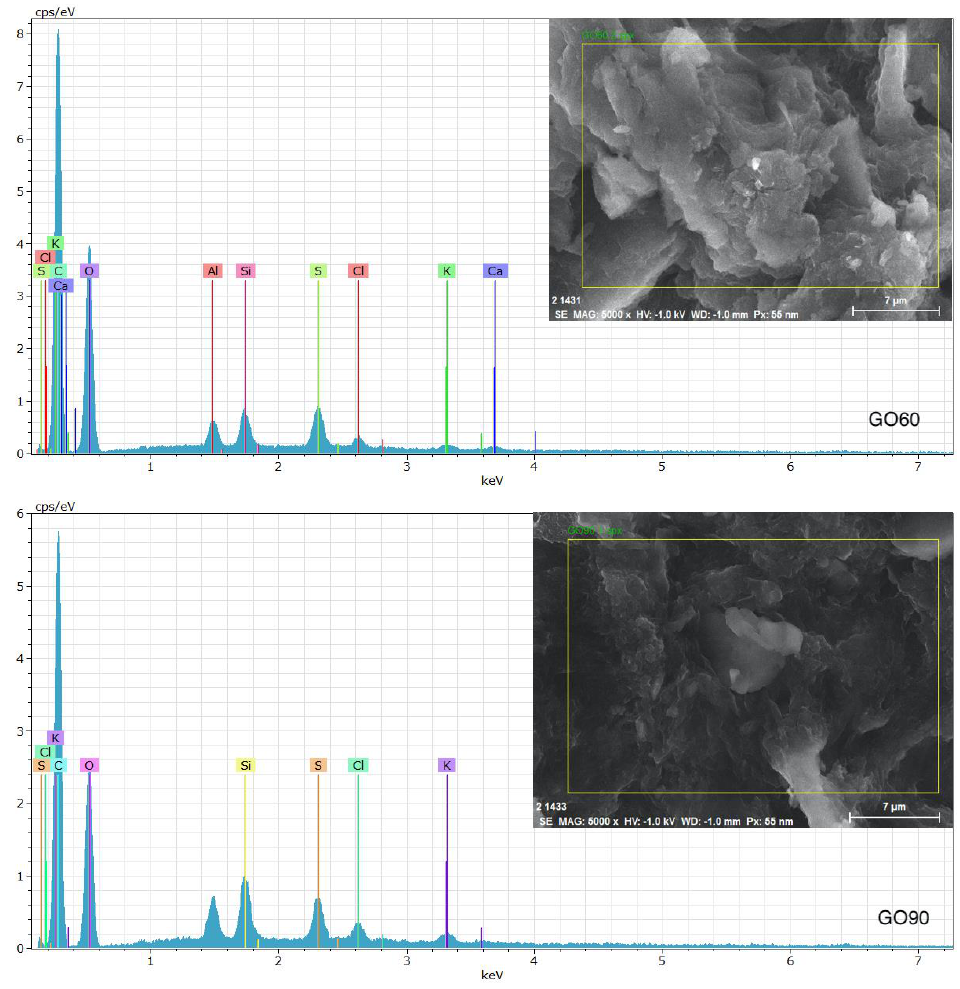
Figure 9. EDS analysis shows the elemental composition of samples GO60 and GO90 .